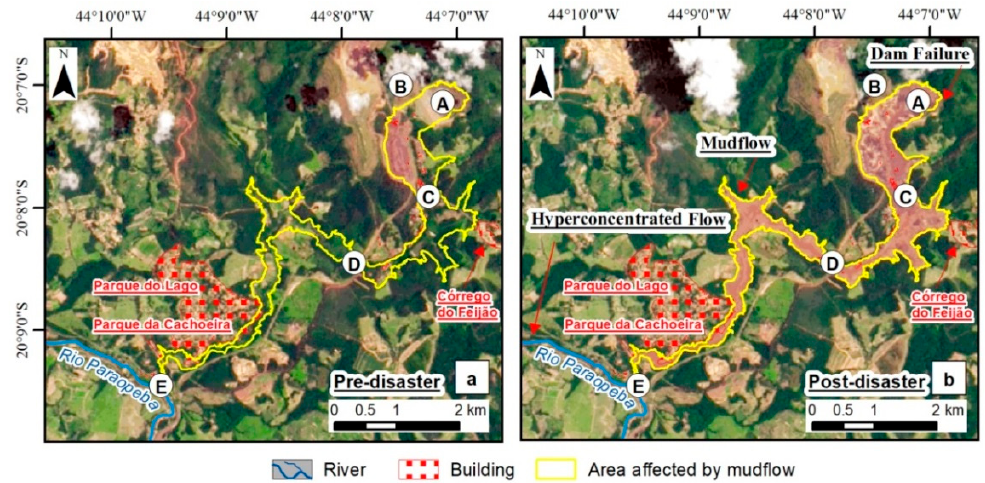
Figure 7. Comparison of pre- and post-disaster Landsat 8 images [64]. ( a ) Pre-disaster remote sensing image (14 January 2019) [27]; ( b ) post-disaster remote sensing image (30 January 2019) [28]. A = location of the destroyed tailings dam and the tailings pond "Barragem I" on 25 January 2019. B = location of tailings pond "Barragem VI" which appeared as an early warning of stability on 27 January 2019. C = location of the destroyed cantina and office buildings. D = location of the destroyed railway bridge (Figure 3b,c). E = location of the entry point of the mudflow into the Paraopeba River.